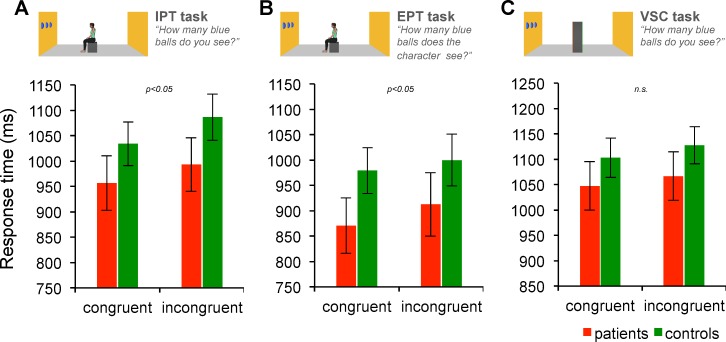
Results for the visuo-spatial perspective-taking tasks (Experiment 1; Response times).Histograms represent the effect of the within-subject factor Viewpoint, which was significant for the implicit perspective-taking (IPT) task (p<0.05) and the explicit perspective-taking (EPT) task (p<0.05), but not for the visuo-spatial control (VSC) task (n.s.: not significant). Data for patients and controls are shown separately for illustration purposes only. Vertical bars represent the standard error of the mean.